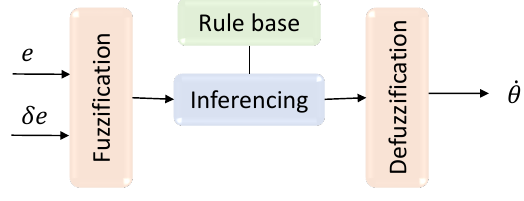
Figure 8. Architecture of the fuzzy logic system.